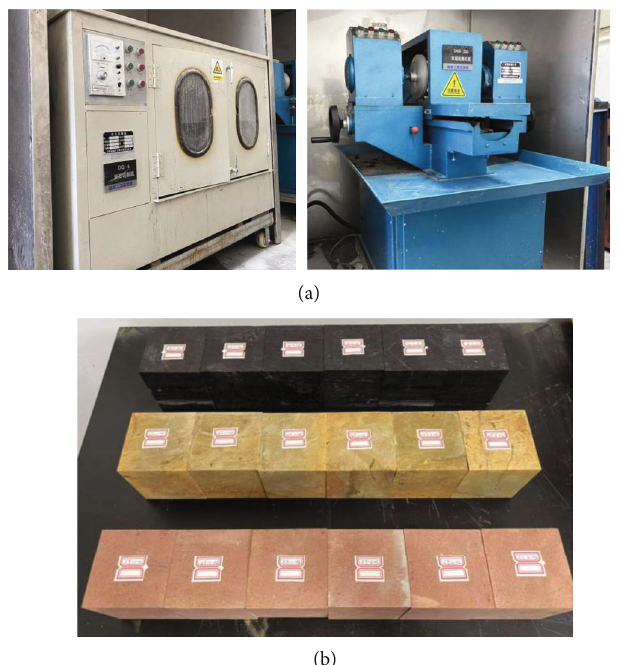
Figure 2: Processing instruments and produced rock samples. (a) Rock sample processing instrumentation and (b) resulting test